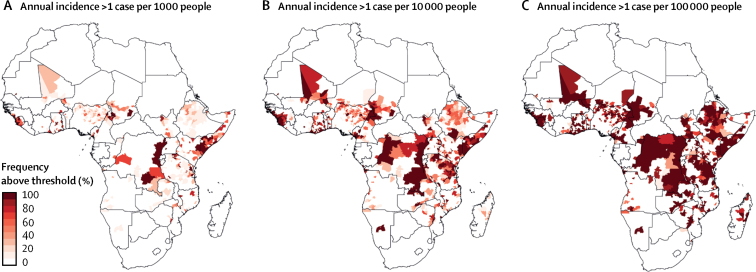
Districts with mean annual cholera incidence above certain thresholds(A) Districts with mean annual cholera incidence of more than one case per 1000 people, (B) more than one case per 10 000 people, and (C) more than one case per 100 000 people. Districts with a mean of fewer than five cases annually are excluded. The colour scale represents the percentage of model iterations (ie, posterior draws) for which incidence exceeds the threshold, with darker shaded districts being over the threshold in a higher percentage of Markov chain Monte Carlo iterations.